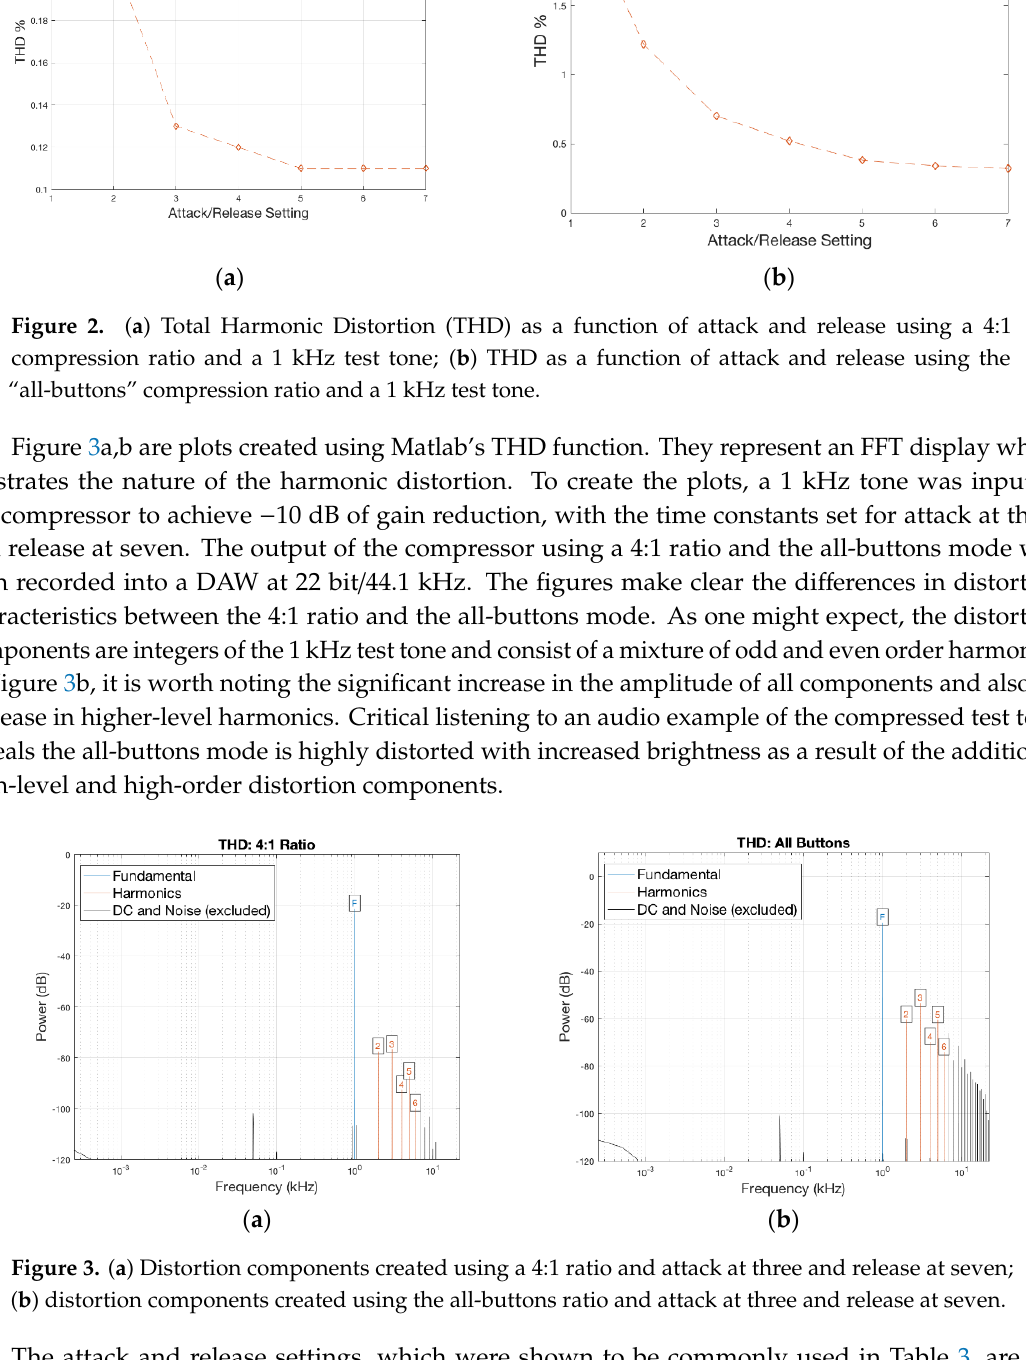
Table 4. THD measurements made using a 1 kHz tone and the time constants and ratios used in Listening Experiment 1.